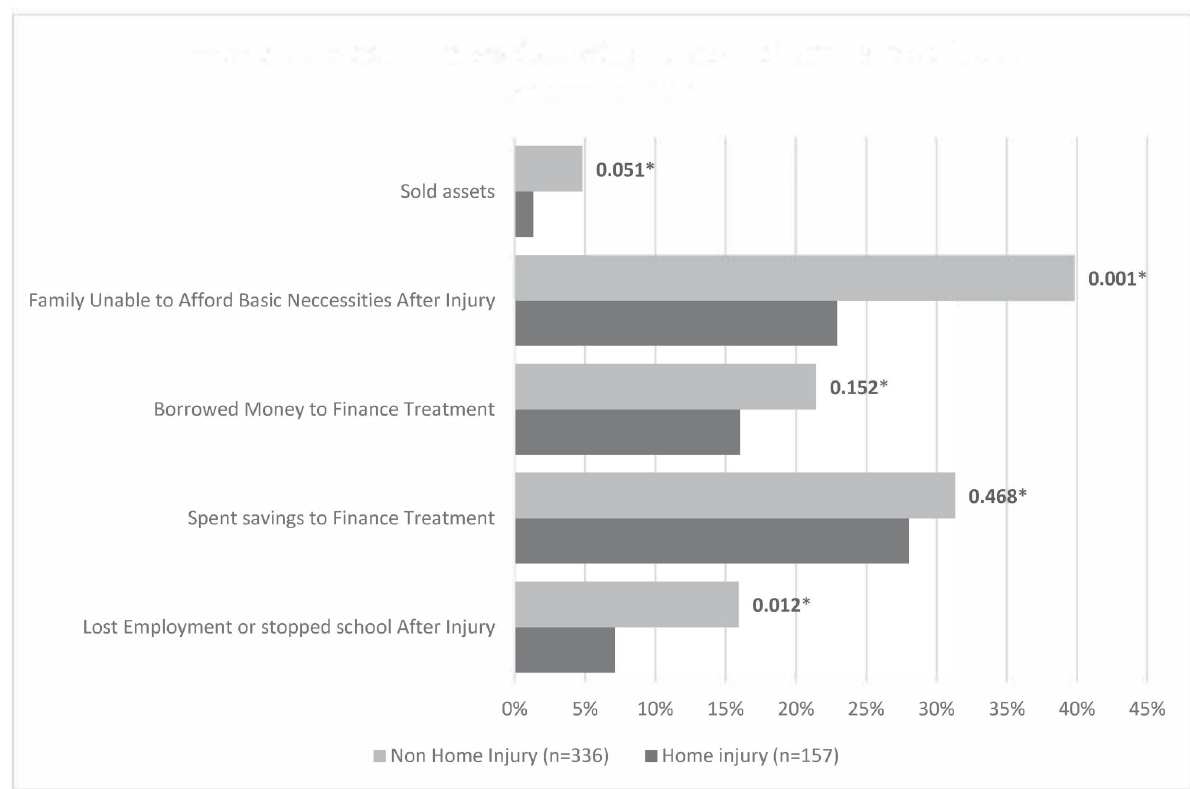
Fig 2. Economic consequences following home injuries in Southwest Region Cameroon. � pvalue: Pearson’s Chi squared test.